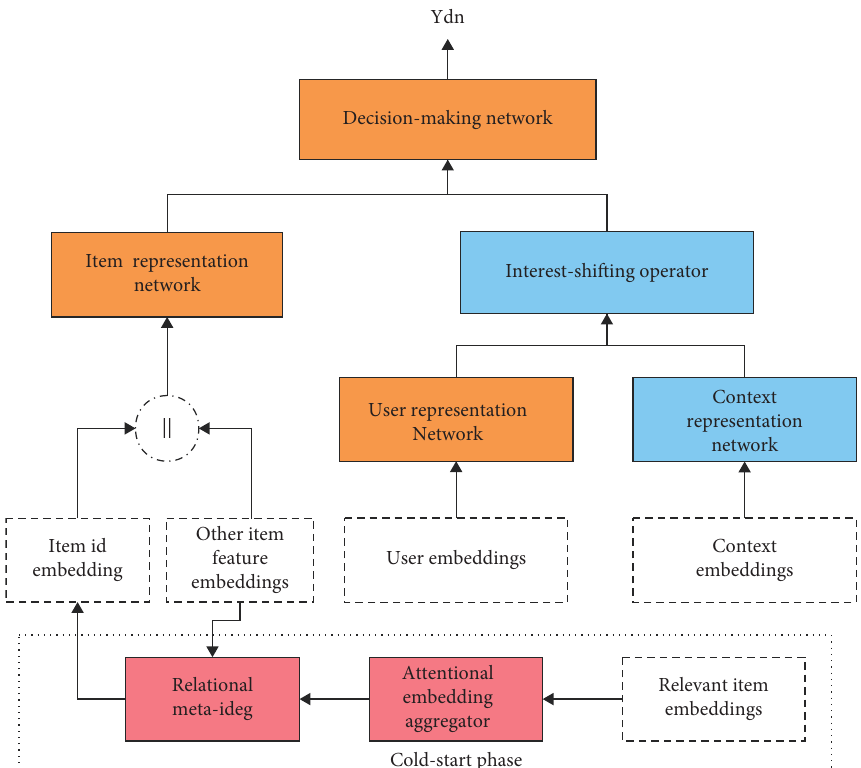
Figure 2: The model architecture of DisNet and RM-IdEG. The orange parts are pretrained using the auxiliary dataset. The blue ones are trained using the warm-start dataset. The pink parts are trained using the cold-start